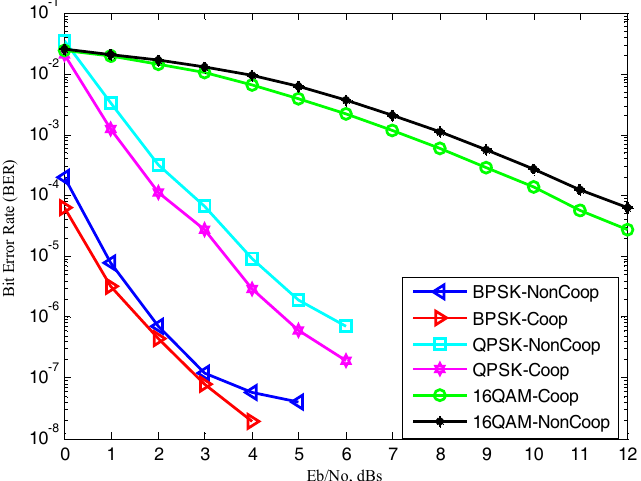
Figure 9. BER performance of turbo coded OFDM with MIMO (2 × 2) antennas in coded-cooperation and non-cooperation based on CMI, L = 1024 , four decoding iterations.